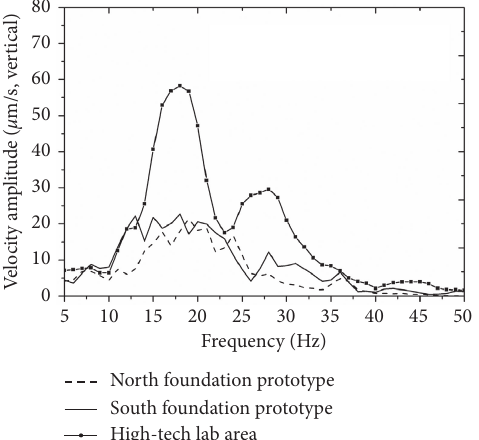
Figure 16: Velocities of ground vibrations at the high-tech lab area and surface vibrations of the foundation prototypes.